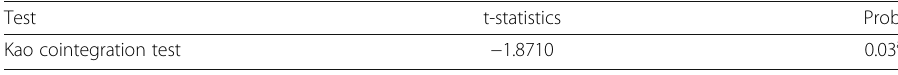
Table 7 Kao Residual Panel Cointegration result